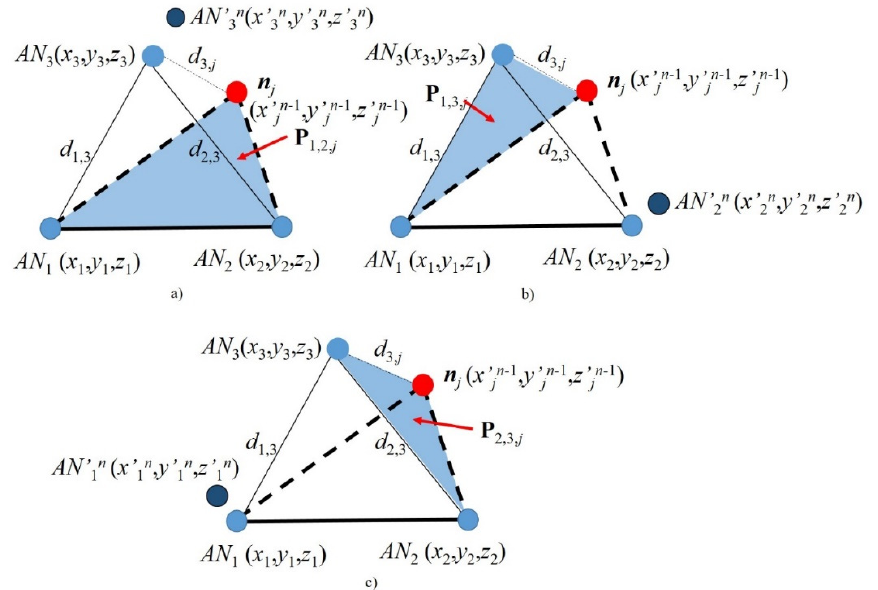
Figure 2. Recursive localization illustration. ( a ) AN 3 self-locating, ( b ) AN 2 self-locating and ( c ) AN 1 self-locating.